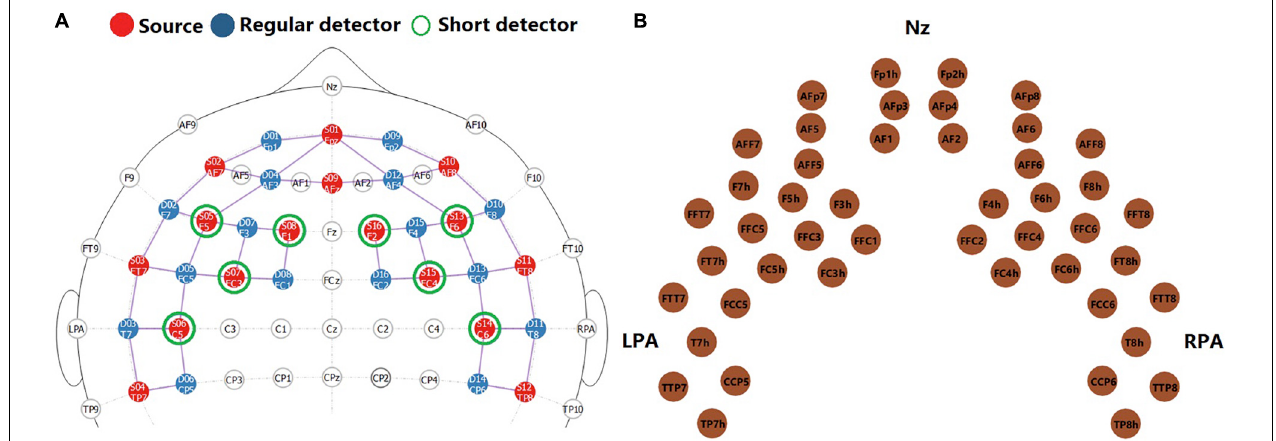
FIGURE 2 | Functional near-infrared spectroscopy montage. Panel (A) shows the locations of light sources (red, n = 16), regular APD detectors (blue, n = 16), and short-channel detectors (green, n = 8) on the 10–10 system. This figure was adapted from NIRSite software (NIRSite 2.0, NIRx Medical Technologies, LLC). Panel (B) shows the middle point of each pair of light source and detector at 3 cm distance, i.e., fNIRS channels ( n = 46).